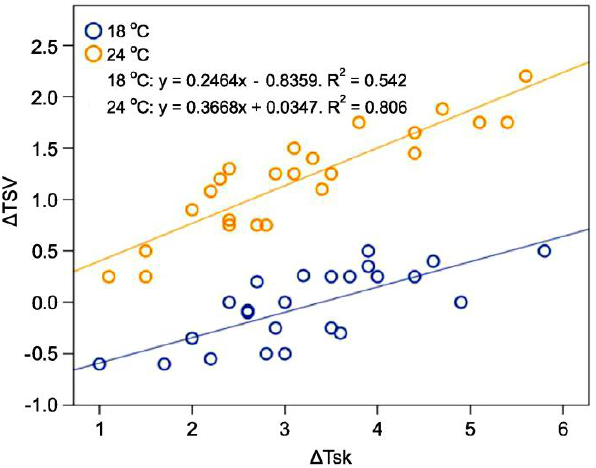
Figure 14. Relationship between ΔTsk and ΔTSV.